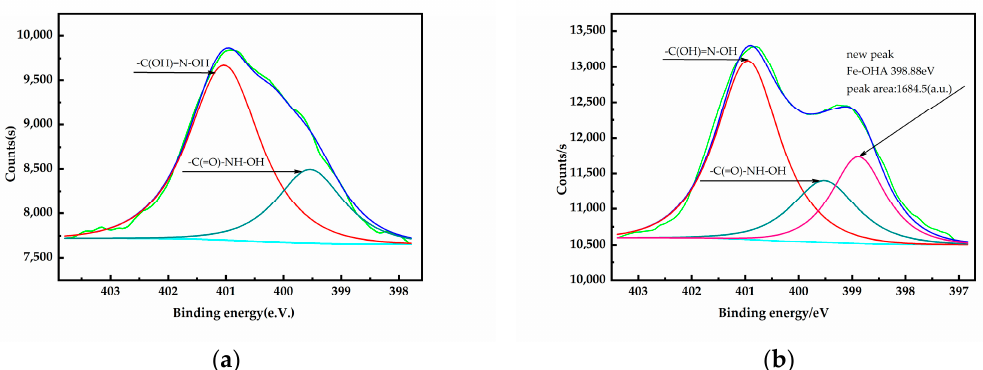
Figure 8. N1s narrow region scan of ( a ) OHA and ( b ) pyrrhotite (ET = 24 h) treated with OHA (OHA concentration: 5 × 10 − 4 mol/L, pH = 8.0).